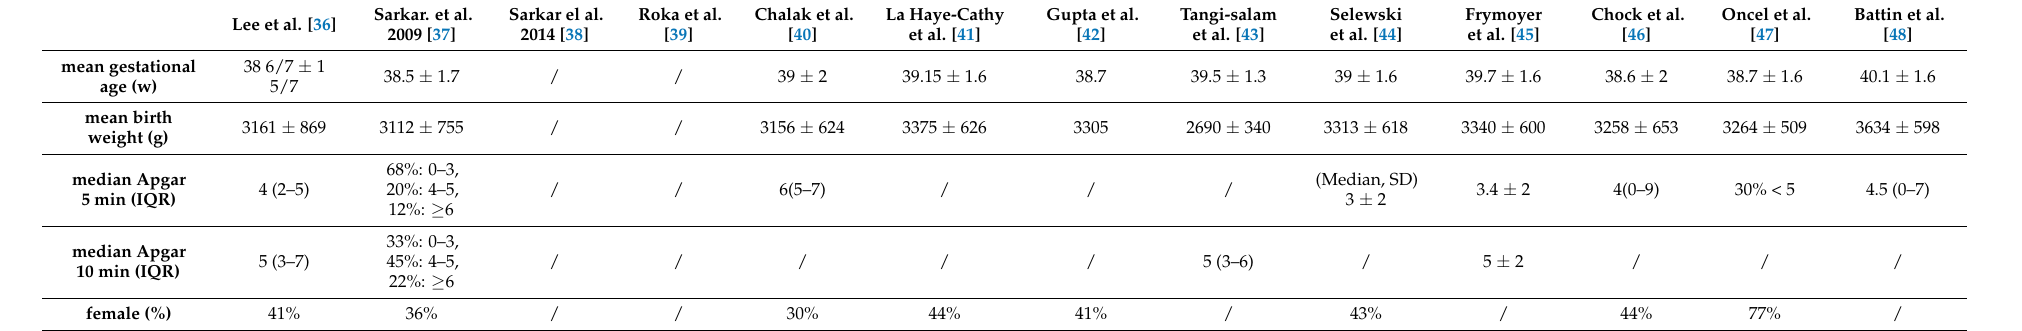
Table 3. Patient characteristics (i.e., gestational age, birth weight, APGAR score at 5 and 10 min, %female) as reported in the retained studies of this meta-analysis (IQR: interquartile range)